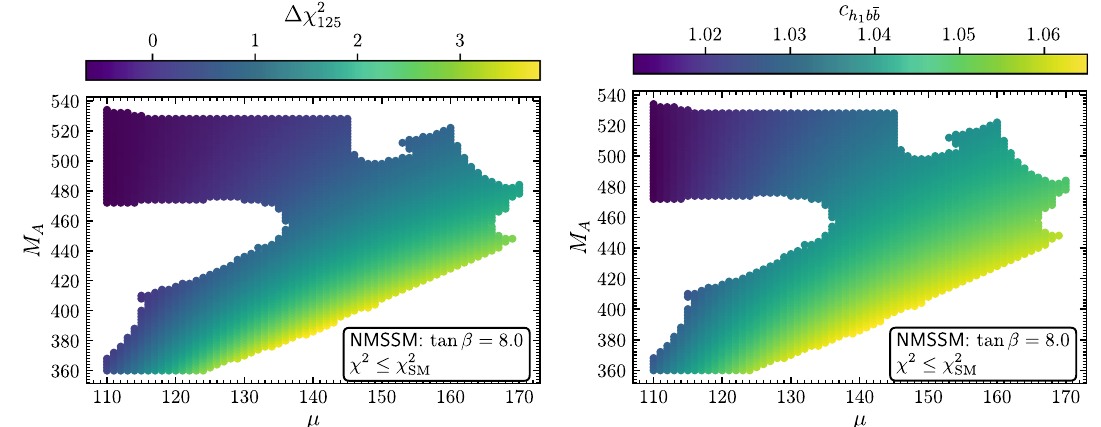
Fig. 16 NMSSM parameter points of the scan (see Table 4) with tan β = 8 . 0 in the plane μ – M A . All shown points have χ 2 ≤ χ 2 HiggsBounds test. The colors of the points indicate the values of (cid:14)χ 2